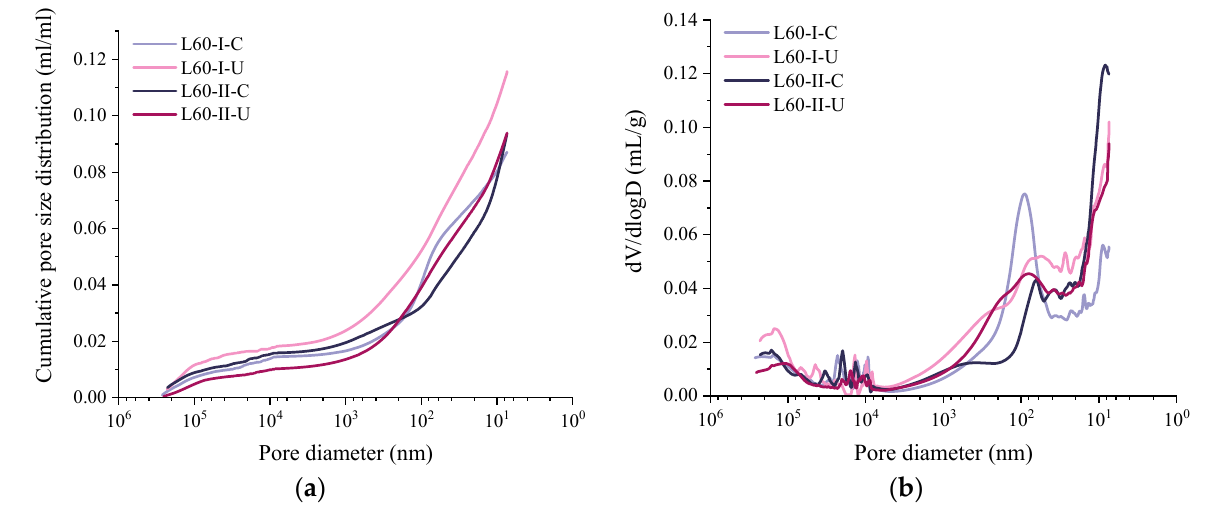
Figure 9. Pore size distribution of samples at different depths and load levels: ( a ) cumulative pore volume; ( b ) pore size distribution curves.